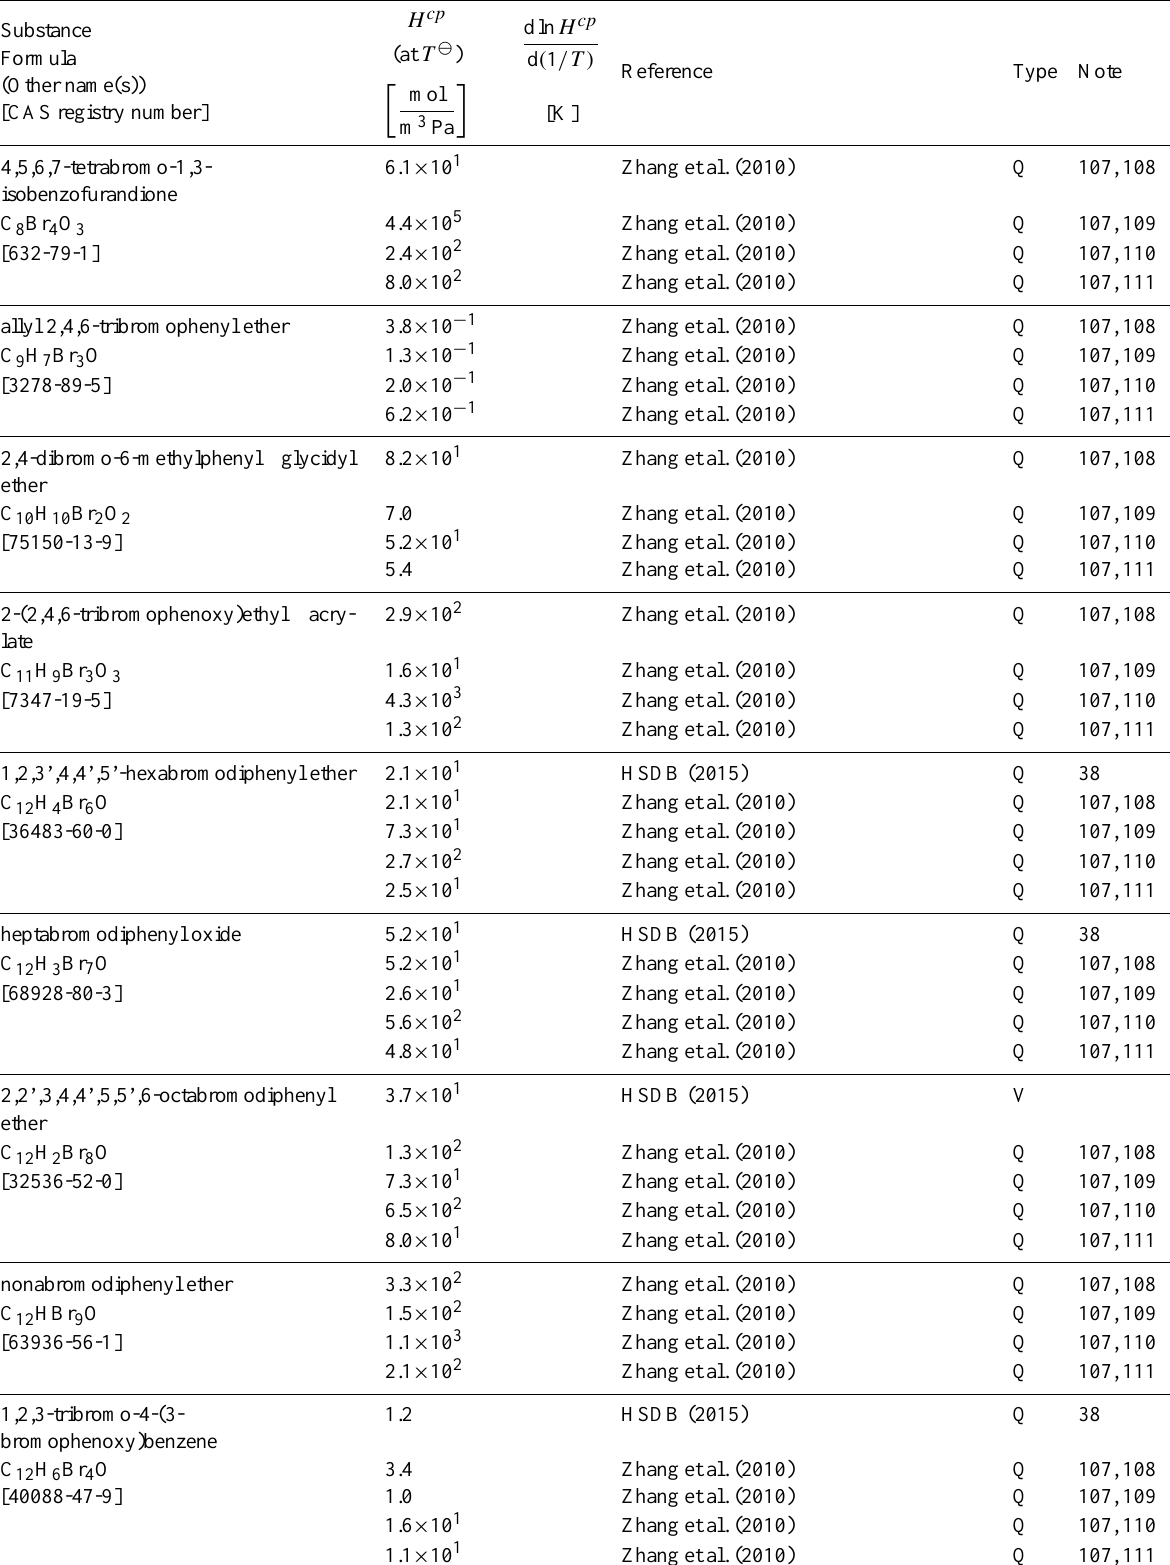
Table 6: Henry’s law constants for water as solvent